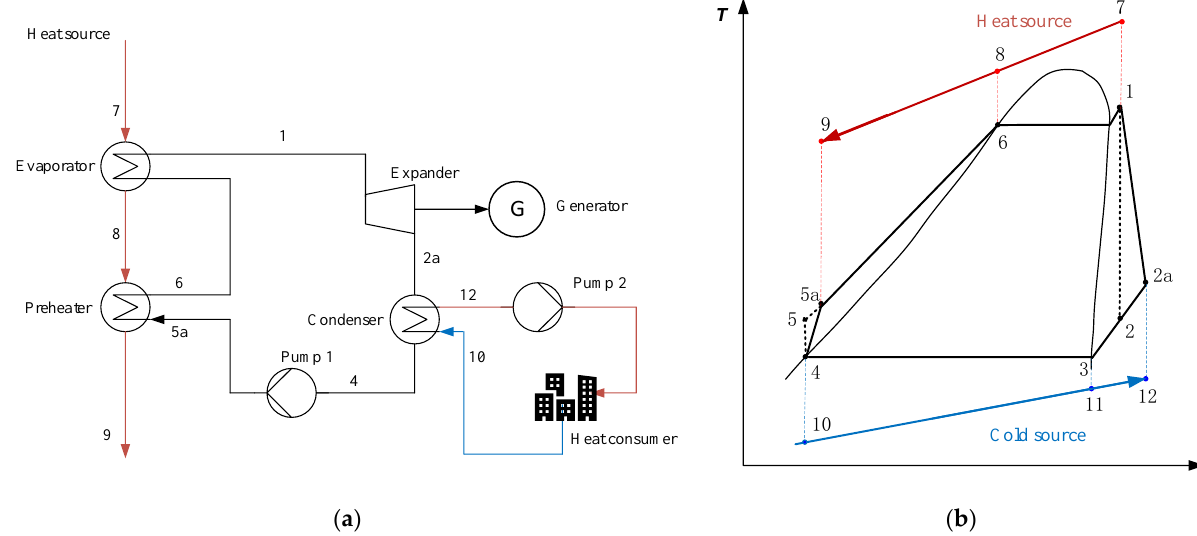
Figure 3. Cycle configuration and T -s diagram of the condensation system: ( a ) cycle configuration and ( b ) cycle T -s diagram.